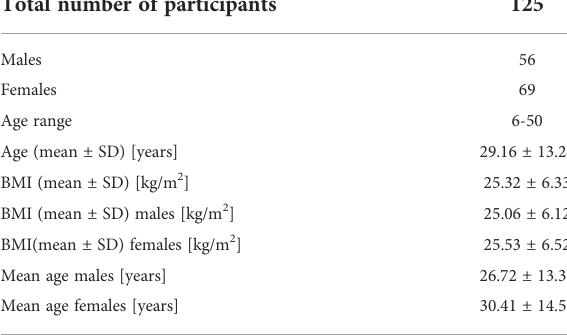
TABLE 1 Demographic characteristics of subjects participating in the